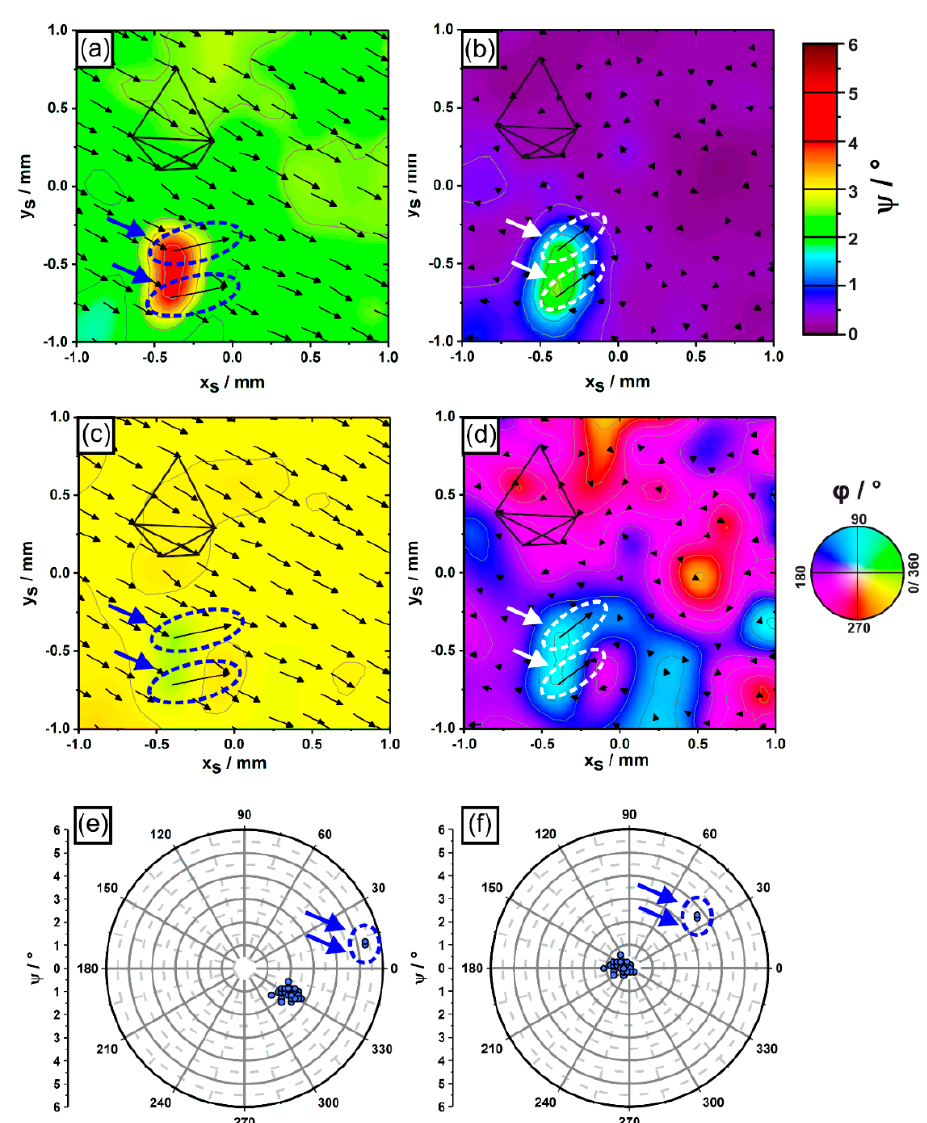
Figure 9. Dendrite growth directions represented by ( a – d ) color-coded contour maps showing local distributions of ( a , b ) polar and ( c , d ) azimuth angles, and by ( e , f ) pole figures. Left sub-figures ( a , c , e ): as-measured dendrite growth directions. Right image part ( b , d , f ): growth directions after compensation of the overall misalignment. The two arrows highlight two outliers. For details, see text.